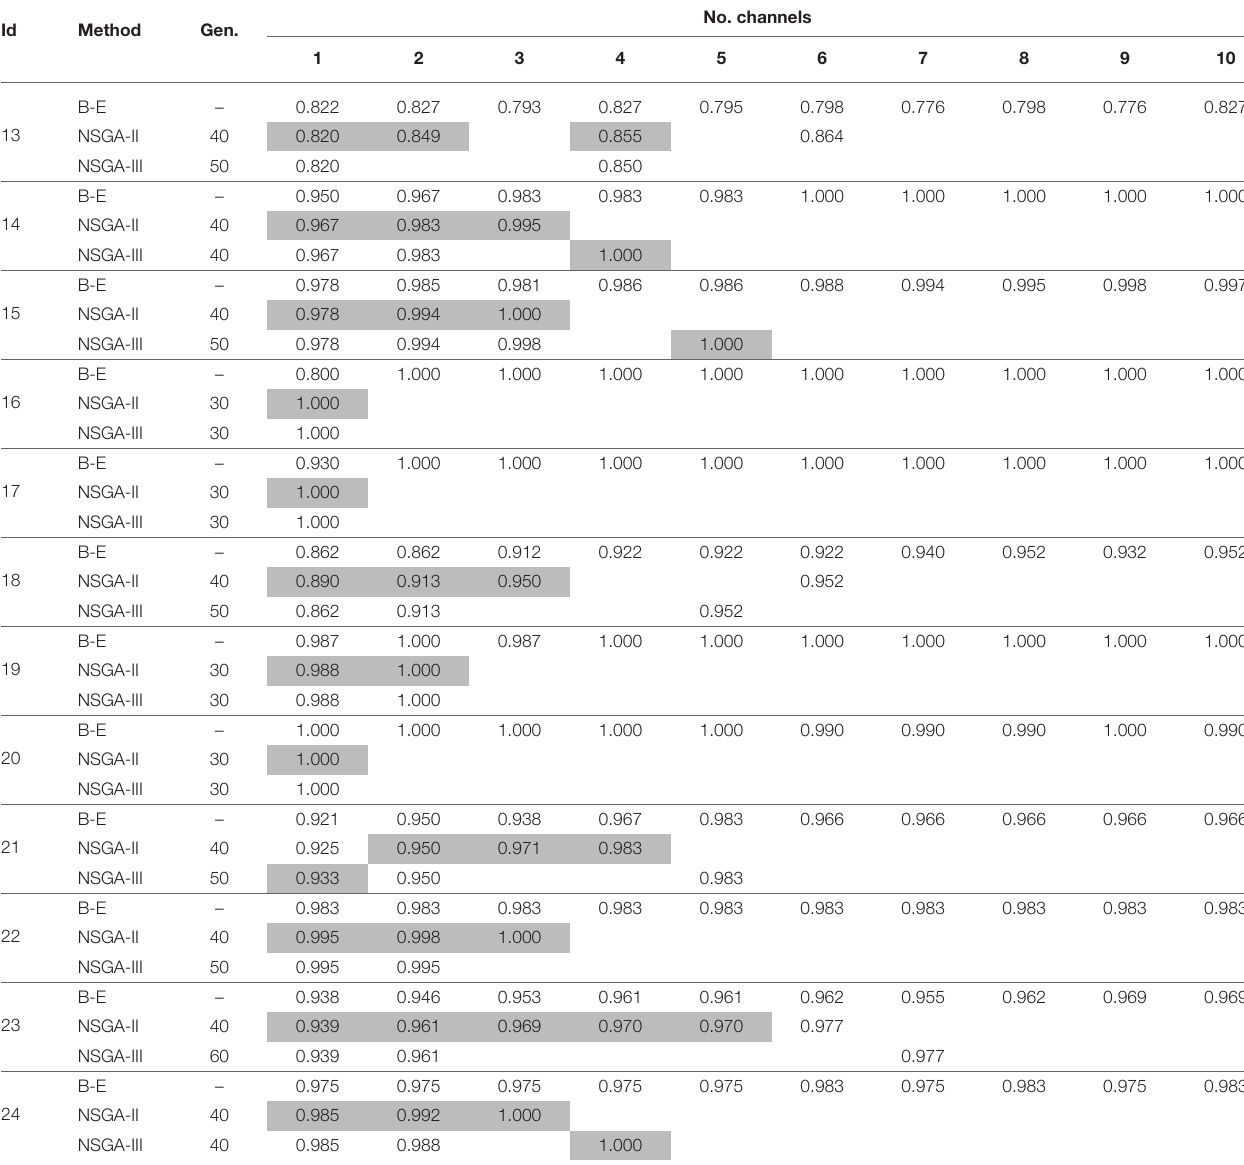
TABLE 4 | Accuracies obtained using DWT for feature extraction with NSGA-II and NSGA-III for EEG channel selection (subjects